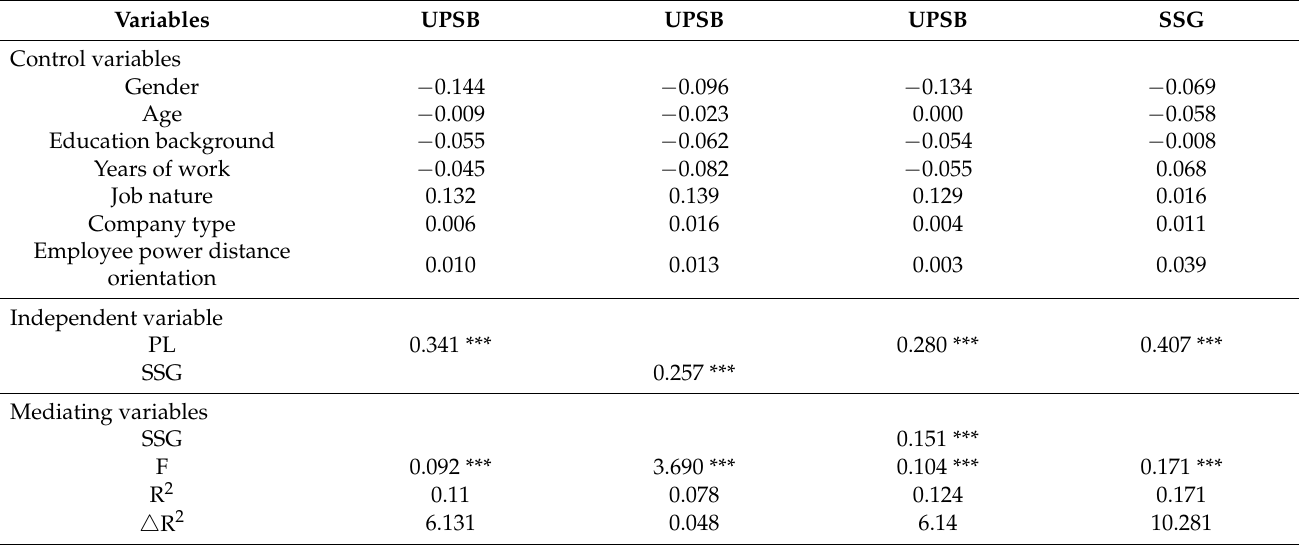
Table 4. Test of mediating effect of SSG.